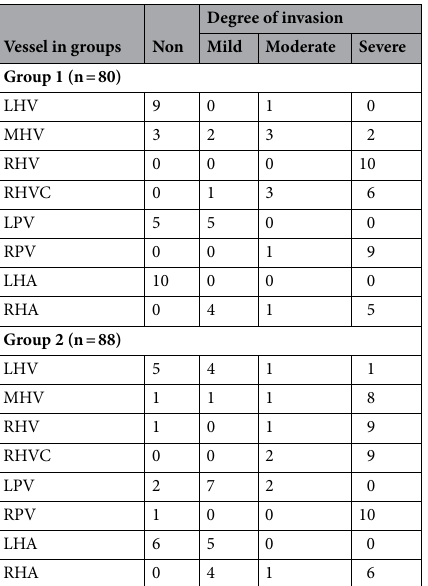
Table 2. The preoperative evaluation of the degree of intrahepatic vascular invasion in all the 21 patients. Notes LHV, left hepatic vein; MHV, middle hepatic vein; RHV, right hepatic vein; RHVC, retrohepatic vena cava; LPV, left portal vein; RPV, right portal vein; LHA, left hepatic artery; and RHA, right hepatic